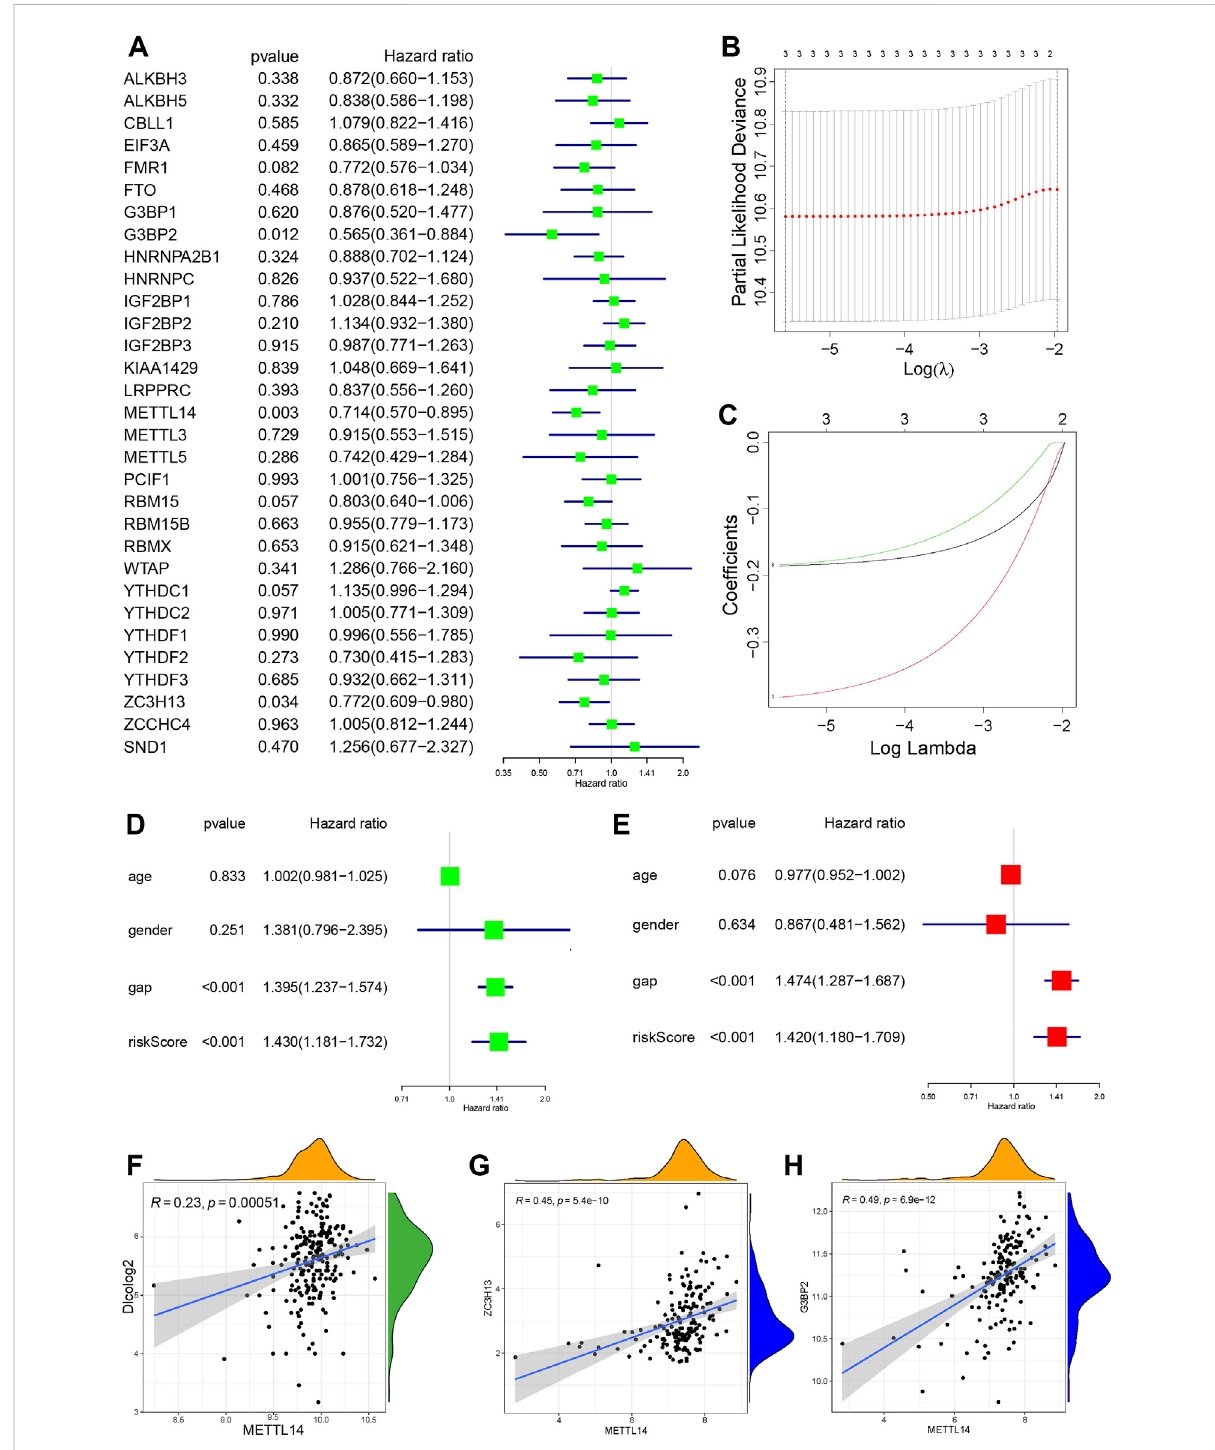
FIGURE 3 Identi fi cationofcharacteristicgenesrelatedto IPFoutcomes (A) Forest plotofthreem6Aregulatorswith p < 0.05byunivariateCoxregression. (B) Selection of the optimal parameter (lambda) in the LASSO regression model. (C) LASSO coef fi cient pro fi les of the three m6A regulators in the GSE70866 series. (D) Forest plot of m6A risk score and three clinical factors by univariate Cox regression. (E) Forest plot of m6A risk score and three clinical factors by multivariate Cox regression. (F) Correlation between METTL14 and DLCO (|R| > 0.2 and p < 0.001). (G) Correlation analysis of METTL14 with ZC3H13 . (H) Correlation analysis of METTL14 with G3BP2 (|R| > 0.4 and p <